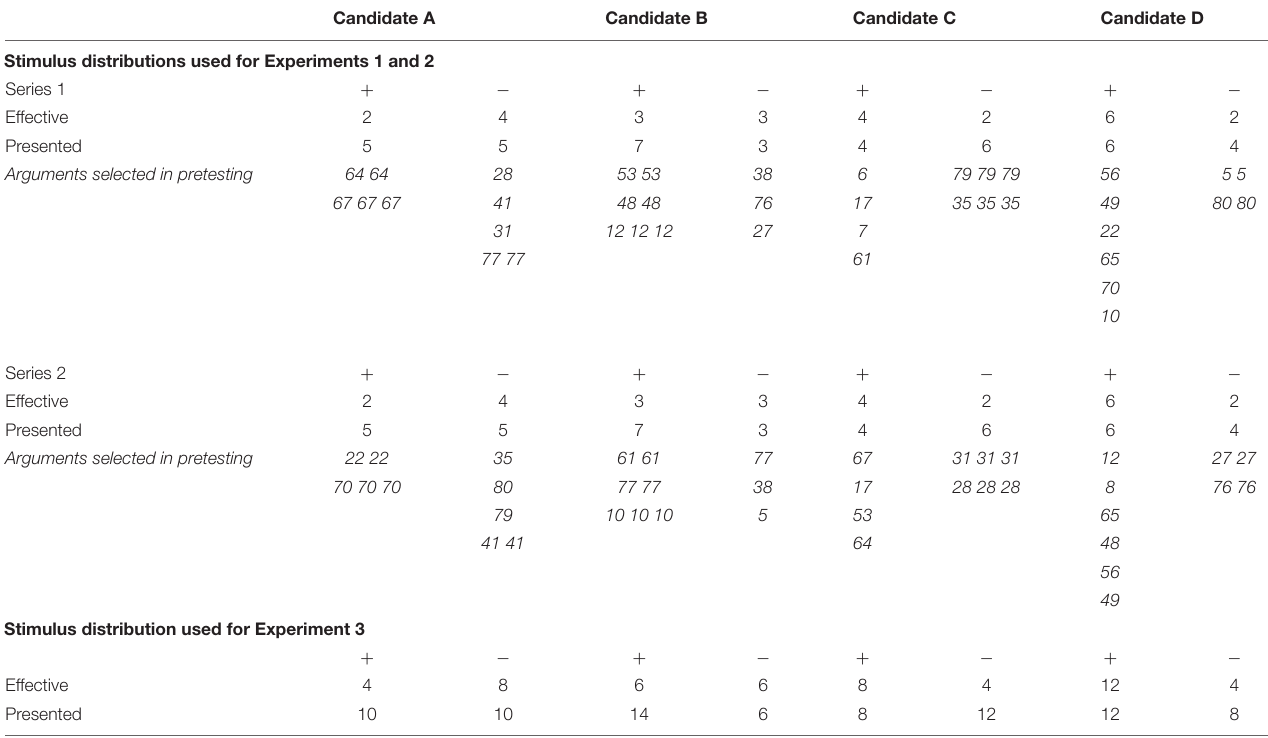
TABLE 2 | Two stimulus distributions (Series 1 and Series 2) used to study repetition